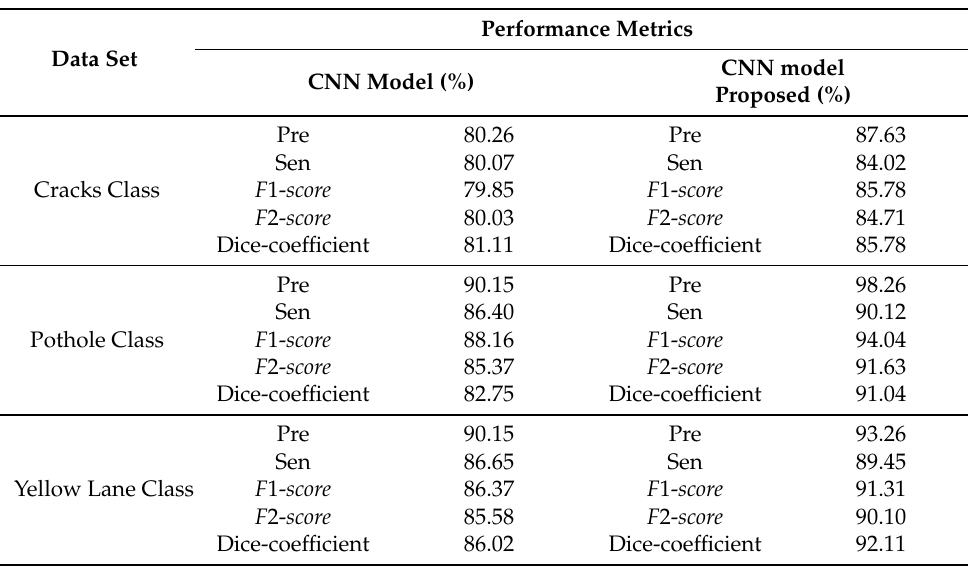
Table 4. Performance comparison with default YOLOv3